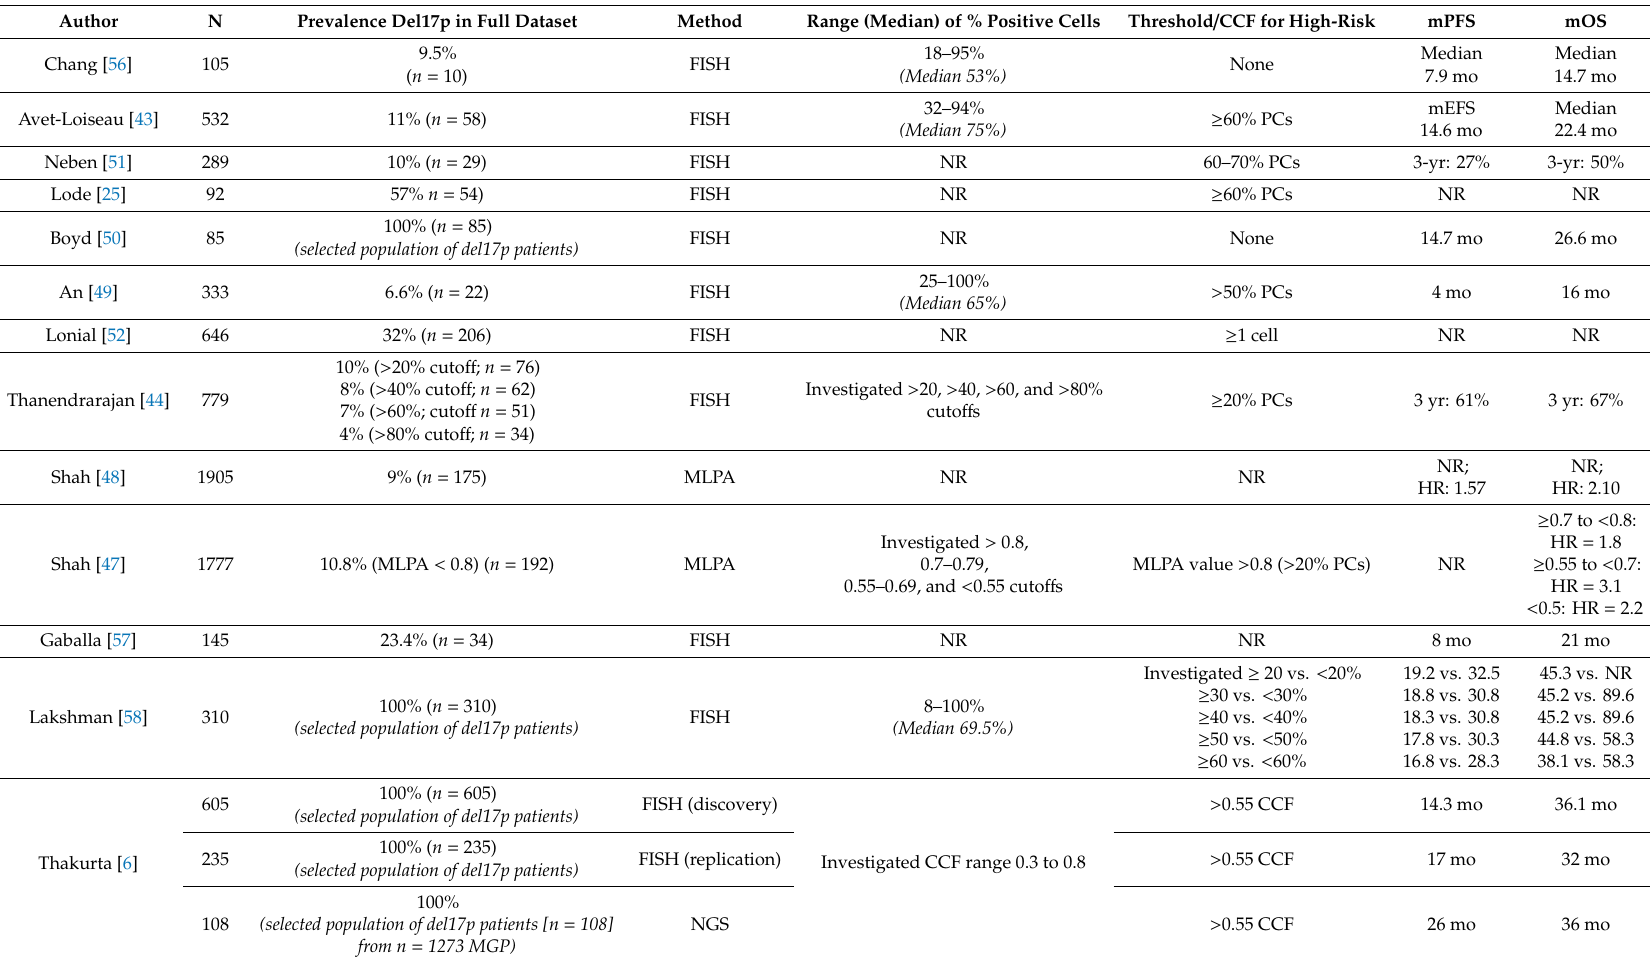
Table 1. Del17p in NDMM Datasets 1